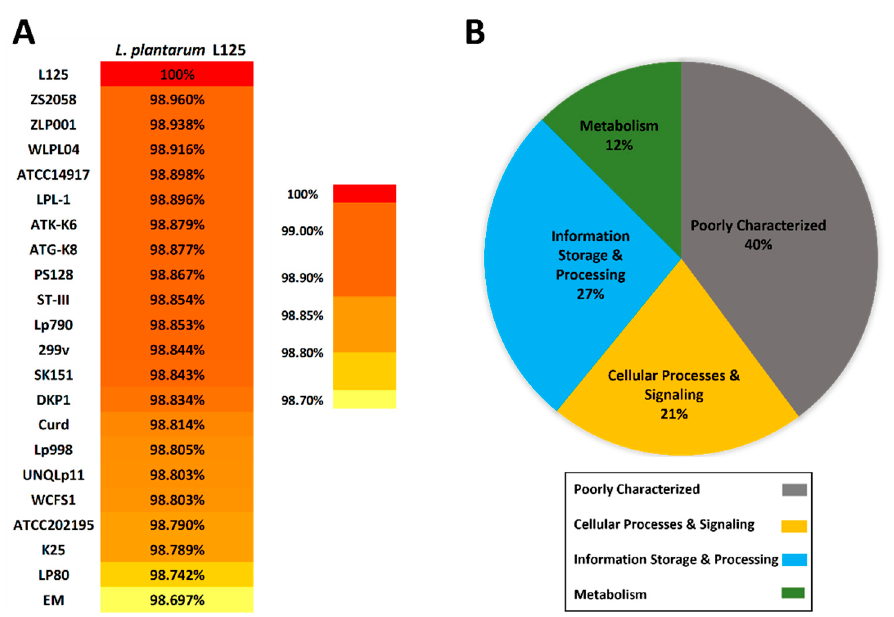
Figure 3. ( A ) Average Nucleotide Identity (ANI) matrix and similarity scores between the coding regions of L. plantarum L125 and the 21 L. plantarum strains. ( B ) L. plantarum L125 strain-specific genes, compared to the 21 L. plantarum strains, assigned to Clusters of Orthologous Groups (COGs) functional categories. “Function Unknown (S)” and “General Function Prediction only (R)” are depicted in the category termed “Poorly Characterized”.